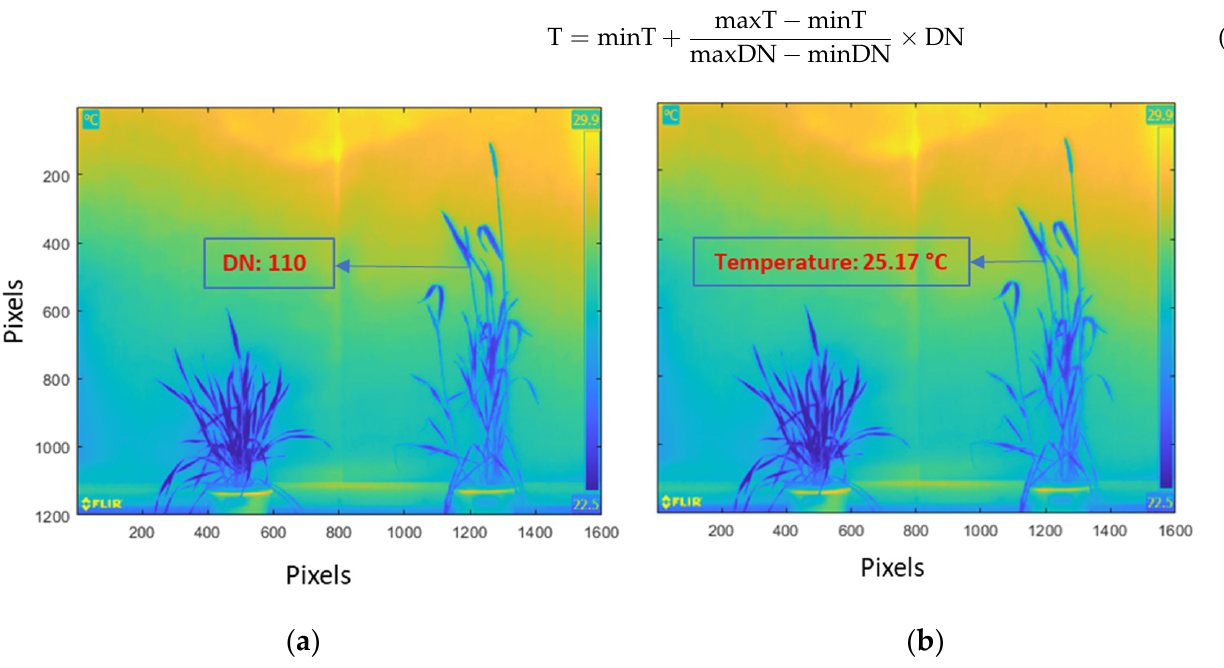
Figure 8. Pixel values of images: ( a ) before radiometric rescaling—the pixel values are stored as Digital Numbers (DNs); ( b ) after radiometric rescaling—the DNs are converted to temperature values. The maximum and minimum temperature values are recorded on the right of the thermal image.